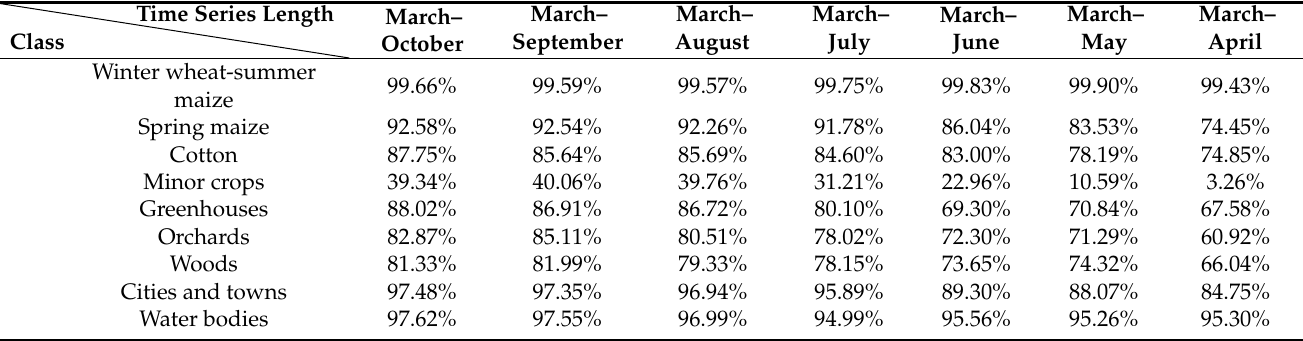
Table A2. Crop identification accuracy of different length NDVI&NDRE time series in 2019.